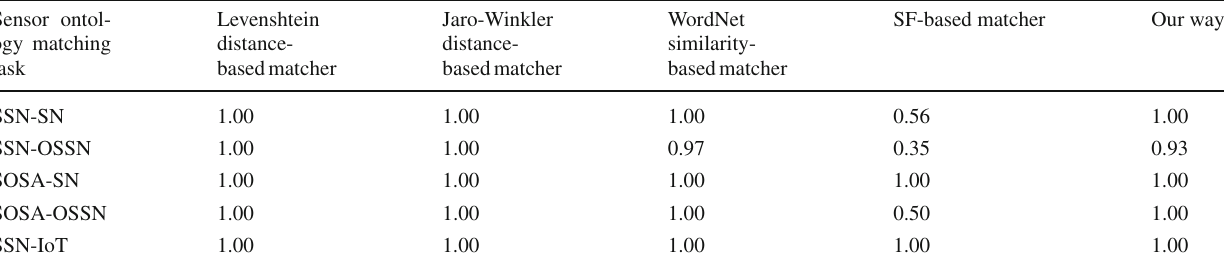
Table 20 Comparison on the proposed method and other classical matchers in terms of recall on sensor ontology test cases Sensor ontol- ogy